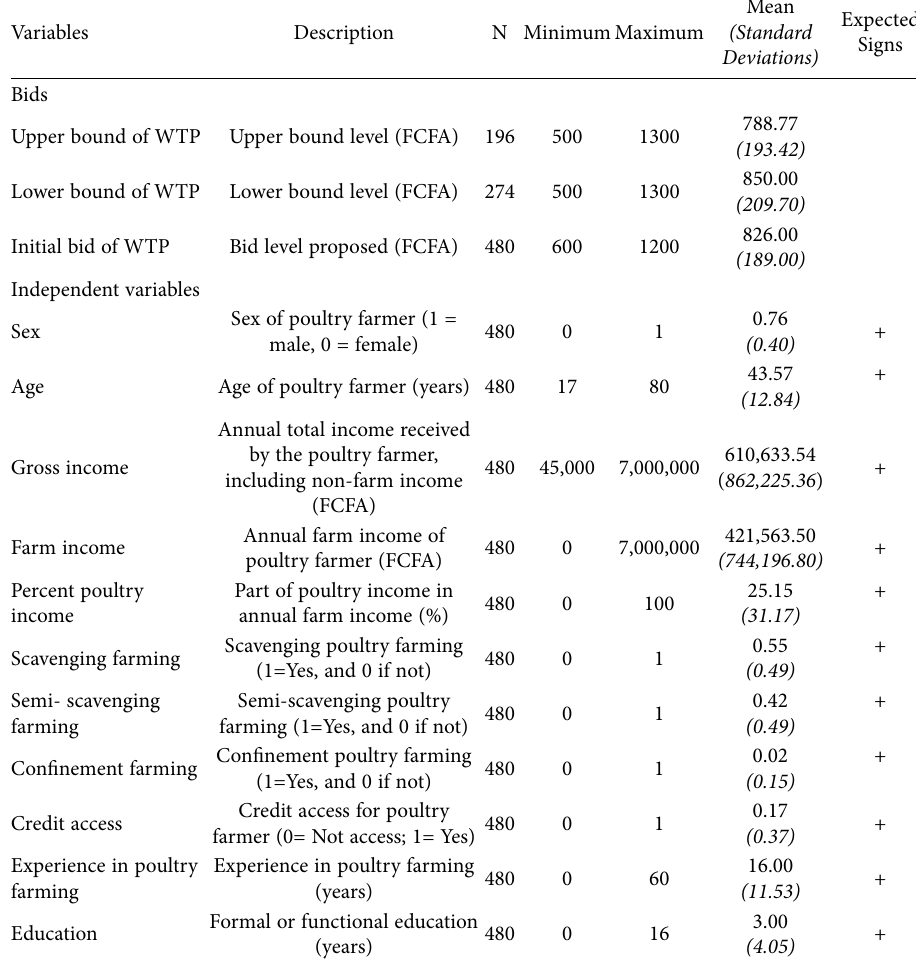
Table 2. Statistics of bids and explanatory variables for